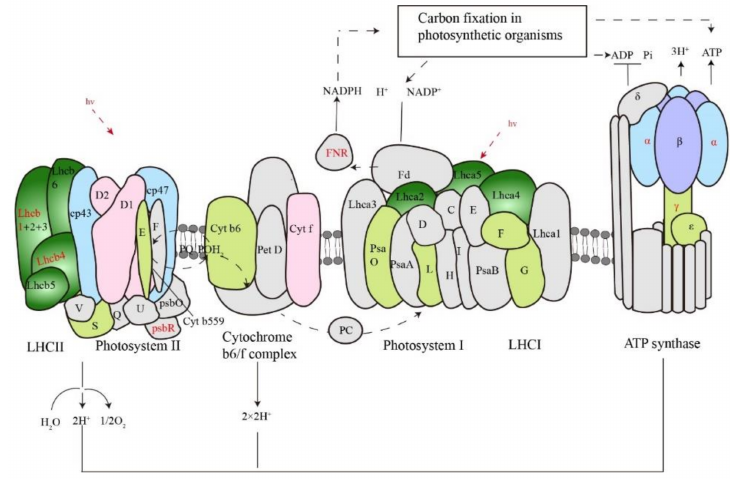
Figure 8. Schematic diagram of photosynthetic complexes on the thylakoid membrane. Cold- responsive proteins at protein abundance levels are shown in colors, while those unquantified or not-responsive are shown in gray. Proteins responsive to cold at site-specific phosphorylation levels are shown in red fonts.